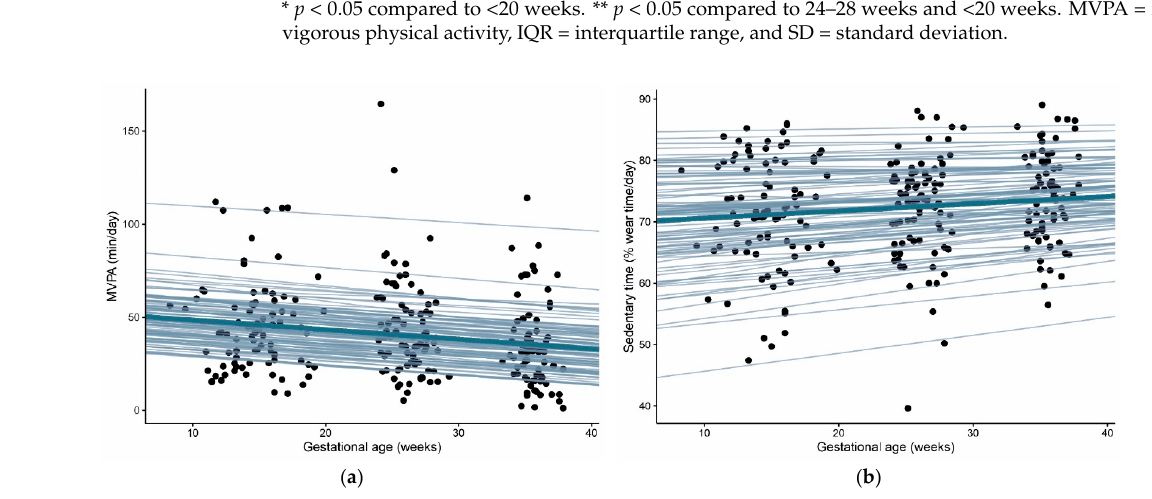
Figure 2. Individual estimates of ( a ) changes in moderate-to-vigorous PA (MVPA) per gestational week and ( b ) changes in % sedentary time (ST) per gestational week. In all women, for MVPA a negative slope, meaning a decrease in MVPA per gestational week was observed. In the majority of women, a positive slope for % ST, meaning an increase in ST, was found. The associations of mean MVPA, mean % ST, changes in MVPA and changes in % ST in pregnancy with the oxidative stress markers are presented in Table 3. Mean MVPA and ST are, respectively, reported in 10 min and 10% units. The changes (slopes) in MVPA and ST are shown in 10 min and 10% changes per four weeks. A higher mean MVPA was associated with lower HSP70 and GCLM mRNA expres- sion in placenta ( − 0.02 AU [95% CI − 0.05, − 0.002] and -0.04 AU [95% CI − 0.08, − 0.01], re- spectively) (Figure 3a). Changes in MVPA or % ST throughout pregnancy were not asso- ciated with any of the other placental outcomes. Adding GDM or prostaglandin use (yes/no) to the models in sensitivity analyses did not change the results meaningfully. 3.3. Sex-Specific Associations of MVPA and ST with Oxidative Markers in the Placenta To identify potential sex-specific responses, all associations were tested for interac- tions with neonatal sex. These analyses found an interaction of % ST with neonatal sex for HO-1, but not for other mRNA outcomes. When the association was assessed in both sexes separately, a significant positive association between HO-1 expression and mean % ST (0.21 AU [95% CI 0.03, 0.39]) (Figure 3b) and changes in % ST (5.84 AU [95% CI 1.85, 9.55]) was only seen in placentas of male neonates.